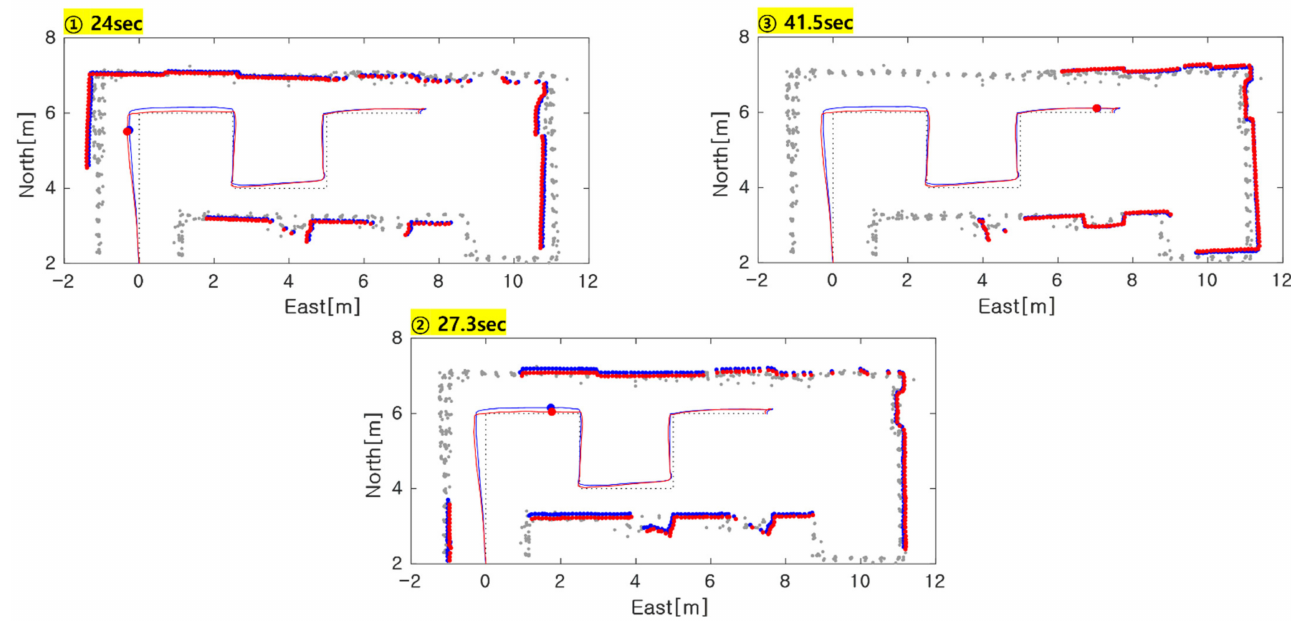
Figure 12. The point cloud data from estimated position by NDT-ICP, NDT-P2P.